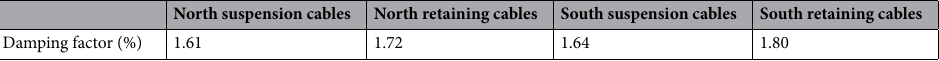
Table 1. Damping factor obtained for the first two families of suspension and retaining